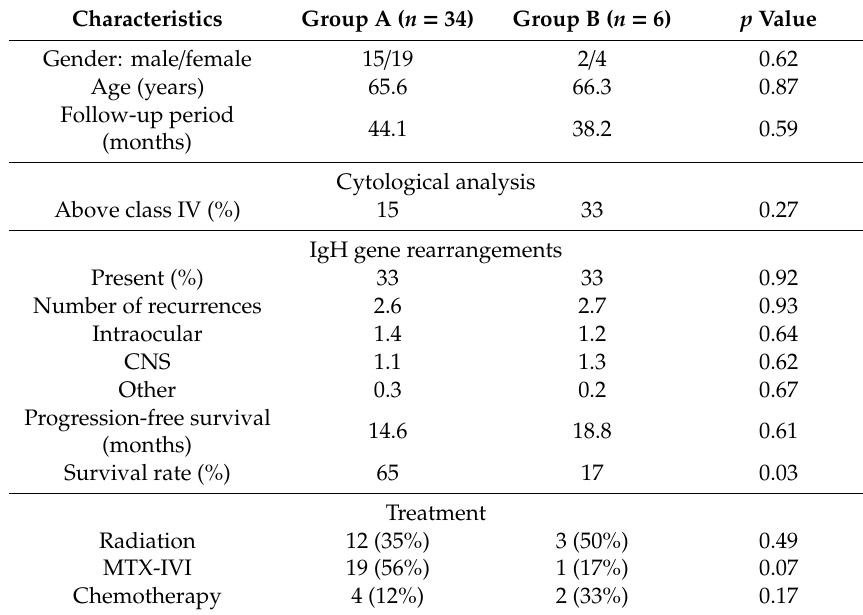
Table 4. Clinical features and treatment in the two groups, classified based on clustering analysis.